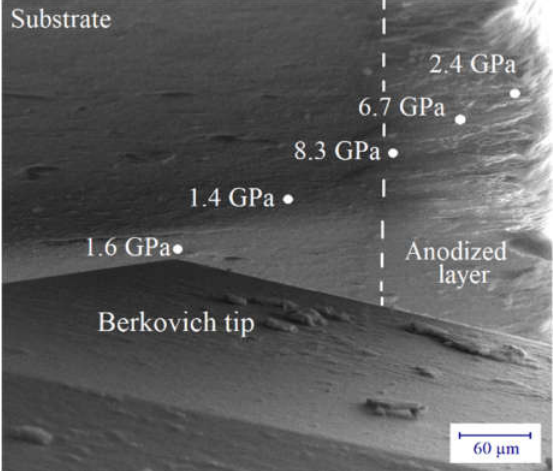
Figure 9. The hardness, H obtained on the cross-section of samples anodized at different current densities for 1 h.